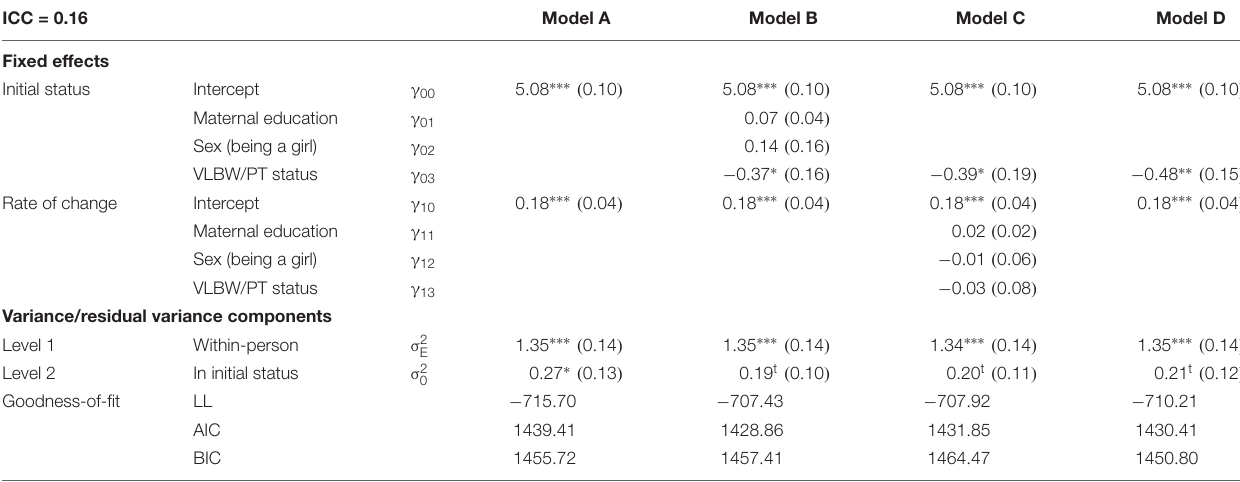
TABLE 5 | The growth models of child responsiveness between 6 and 57 months. ICC = 0.16